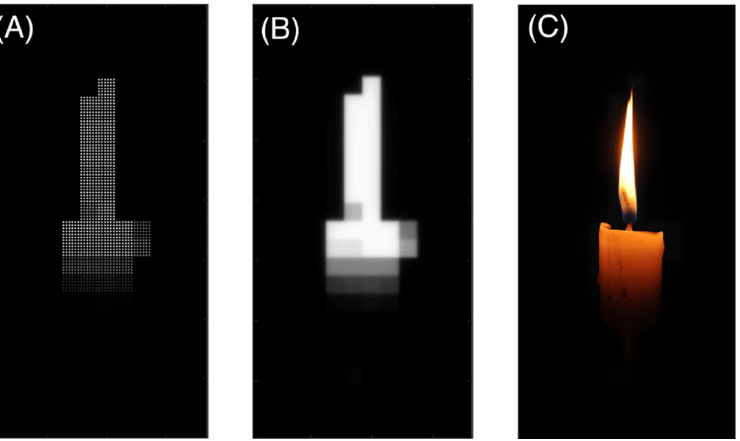
Figure 4. Displayed image simulation:( A ) Mini-LED backlight modulation; ( B ) Luminance distribution of the light incident on LC layer, and ( C ) Displayed image after LCD modulation [25] .